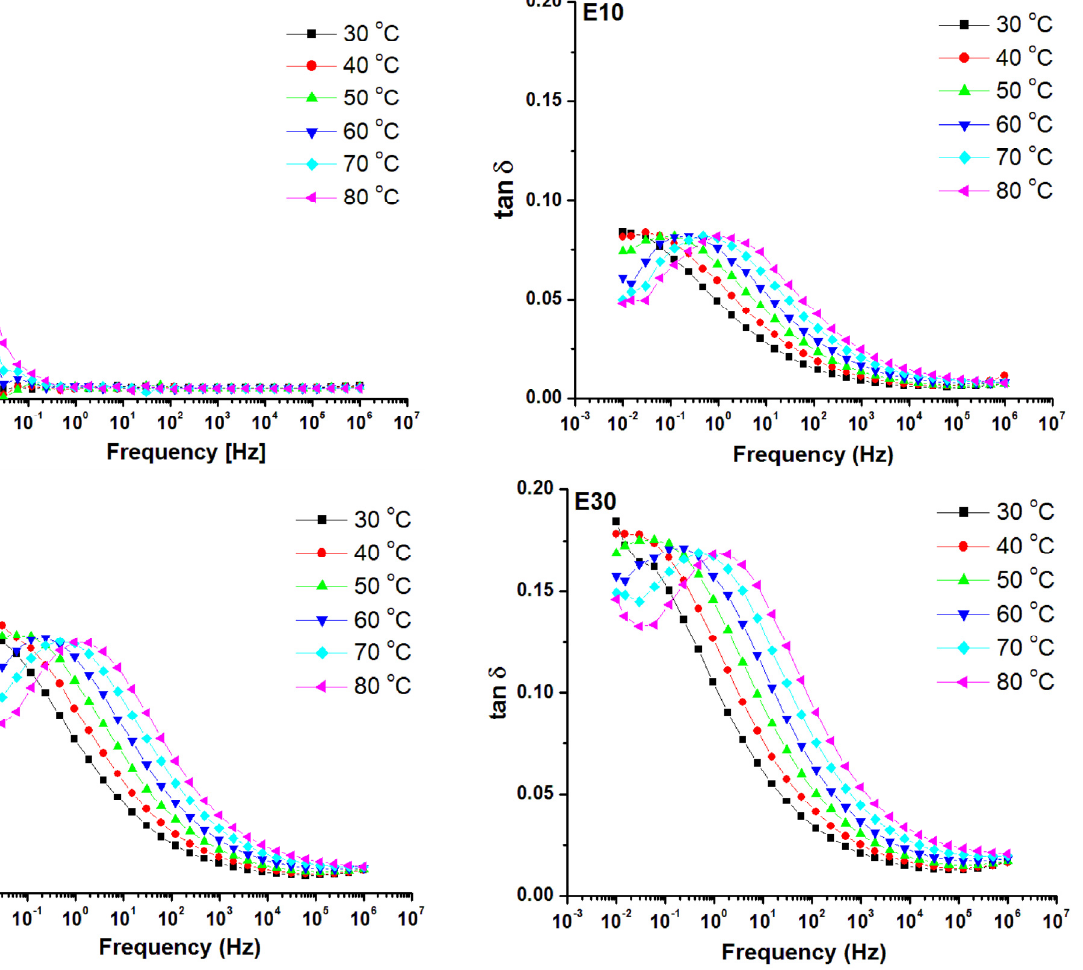
Figure 12. Dependence of tan δ versus frequency for temperatures in the range 30–80 °C for unmodified polysiloxane (E0) and nanocomposites (E10, E20 and E30).